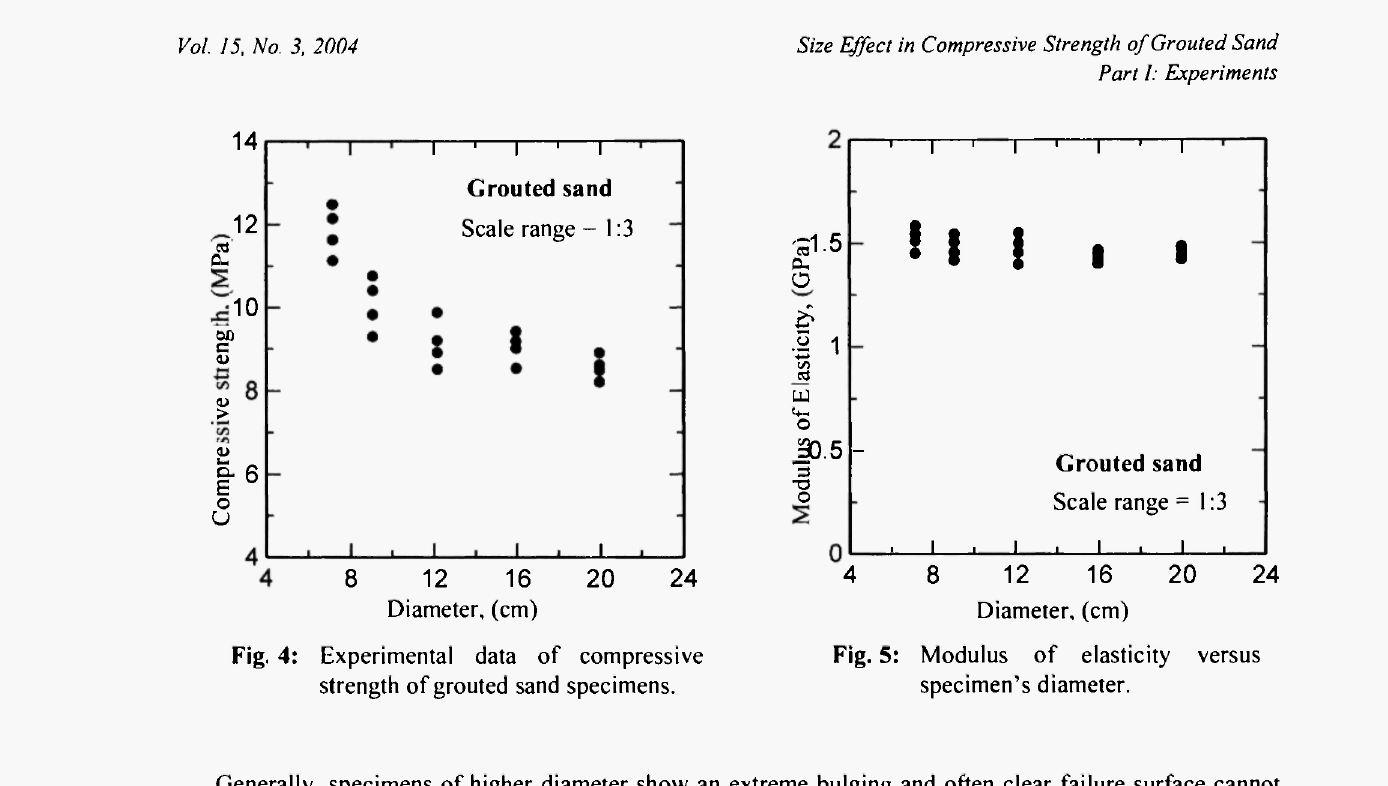
Fig. 5: Modulus of elasticity versus specimen's diameter.